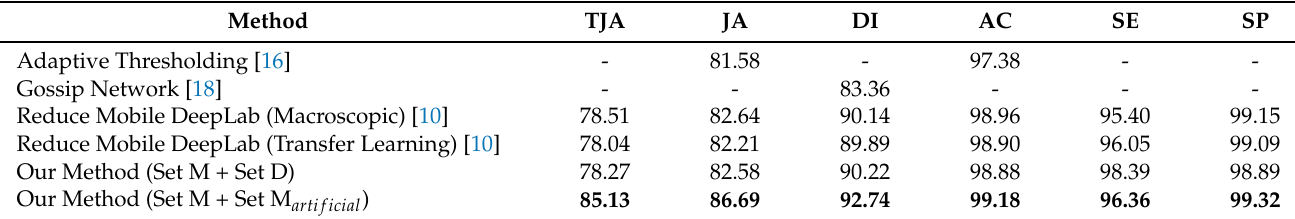
Table 5. Comparison between the proposed methods and related studies using the SMARTSKINS database. The best result, for each of the metrics in the present table, is identified in boldface.